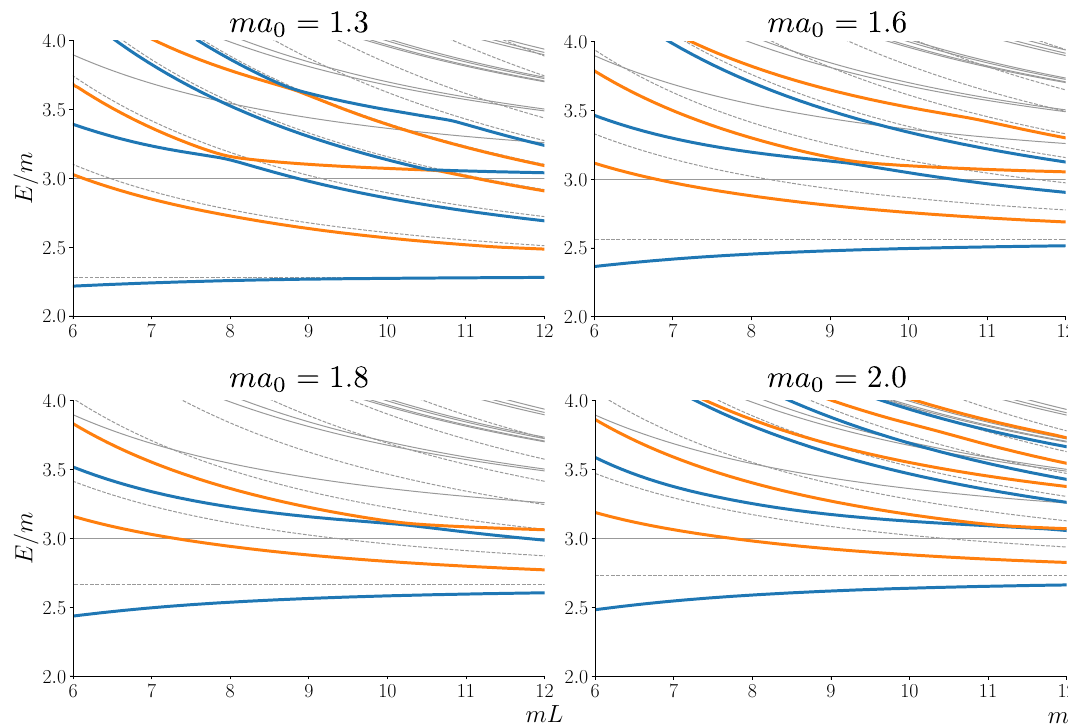
Figure 4 . The spectrum for four values of ma 0 and K iso = 0 as a function of mL . All four df ; 3 values lead to relativistic two-particle bound states. Solid grey lines show the energies of three noninteracting particles (1+1+1 states), while dashed grey lines give the energies of noninteracting dimer + particle states (2+1 states). The interacting energy levels are shown in alternating colors to emphasize the avoided level crossings. Although it is not apparent from these plots, by going to larger values of mL we (cid:12)nd that the lowest state for ma 0 = 1 : 6, 1 : 8, and 2 : 0 is a trimer, while that for ma 0 = 1 : 3 asymptotes to the dimer + particle energy as mL ! 1 . See the text for further